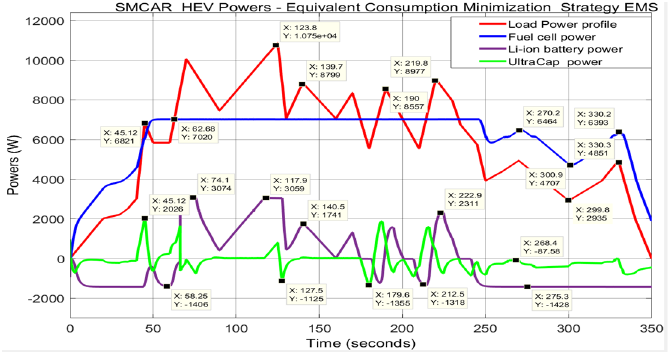
Figure A6. EMS-equivalent consumption minimization strategy setup.